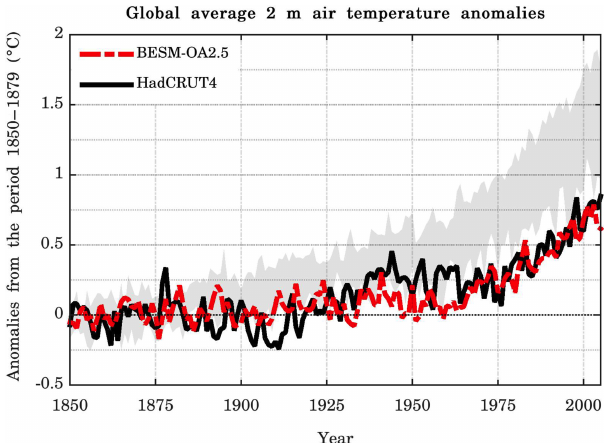
Figure 2. Global averaged 2m annual mean air temperature anoma- lies relative to the period 1850–1879 as simulated by BESM-OA2.5 (dashed red line) and observed (solid black line). The grey shading represents the spread of 11 CMIP5 models (historical GHG simu- lations). The CMIP5 model anomalies were also computed relative to the period 1850–1879, with the exception of GFDL-ESM2M and HadGEM2-ES whose anomalies were computed relative to the pe- riods 1861–1890 and 1860–1889, respectively. Units are in degrees